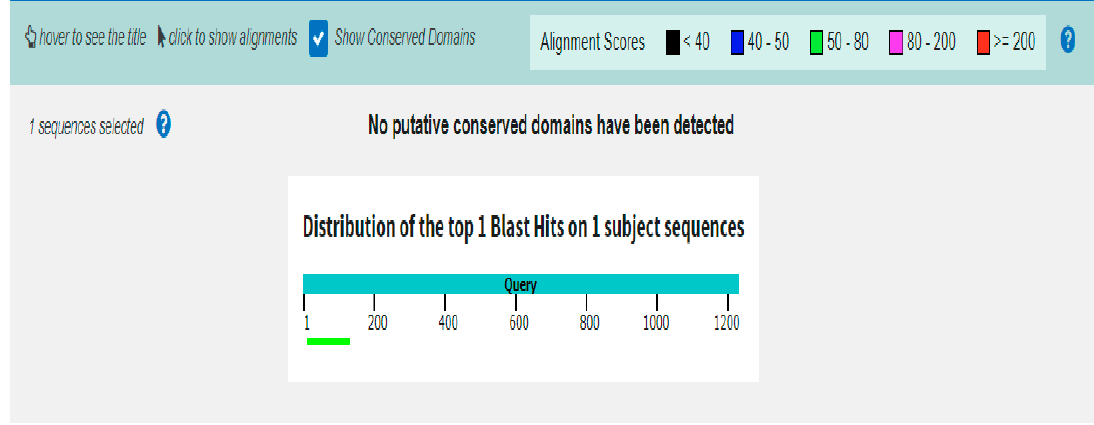
Figure 12. BLASTx analysis of TPD1 promoter showing no coding region and conserved domains.